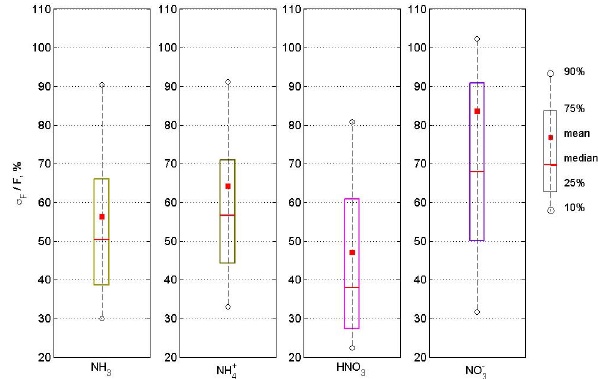
Fig. 14. Statistical representation of the relative flux error ( σ F / F ) Fig. 15. Statistical representation of the relative flux error ( σ F / F ) for NH 3 , particulate NH + , HNO 3 , and particulate NO − during for NH 3 , particulate NH + , HNO 3 , and particulate NO − during 4 3 4 3 NEU in Oensingen (Switzerland), 2006 (managed grassland ecosys- EGER in Waldstein (Germany), 2007 (spruce forest ecosystem). tem). Only data derived from significant values of 1C are used. Only data derived from significant values of 1C are